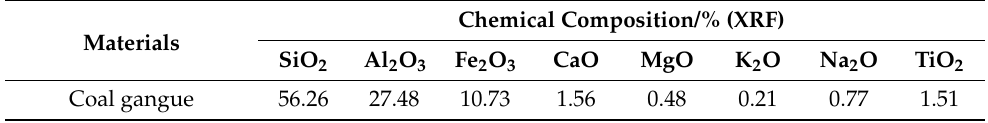
Table 1. Chemical composition of coal